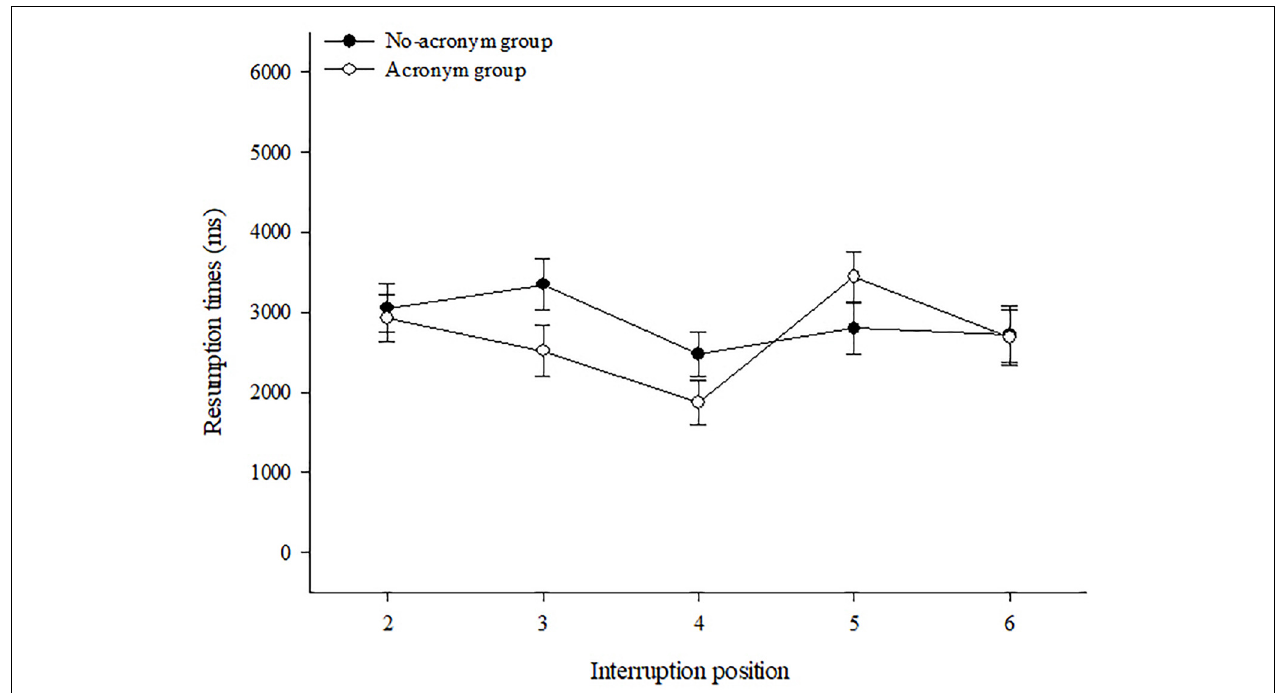
FIGURE 2 | Resumption times and standard errors of the acronym and no-acronym group for different interruption positions.